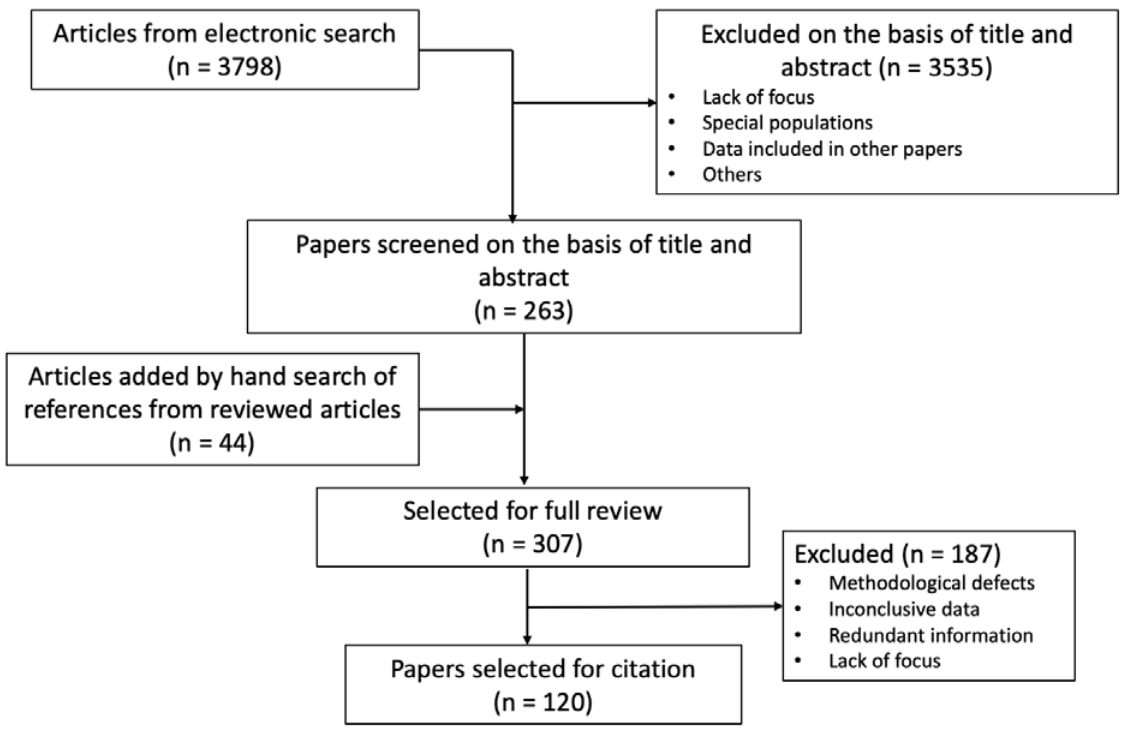
Figure 2. Flowchart of the literature search.